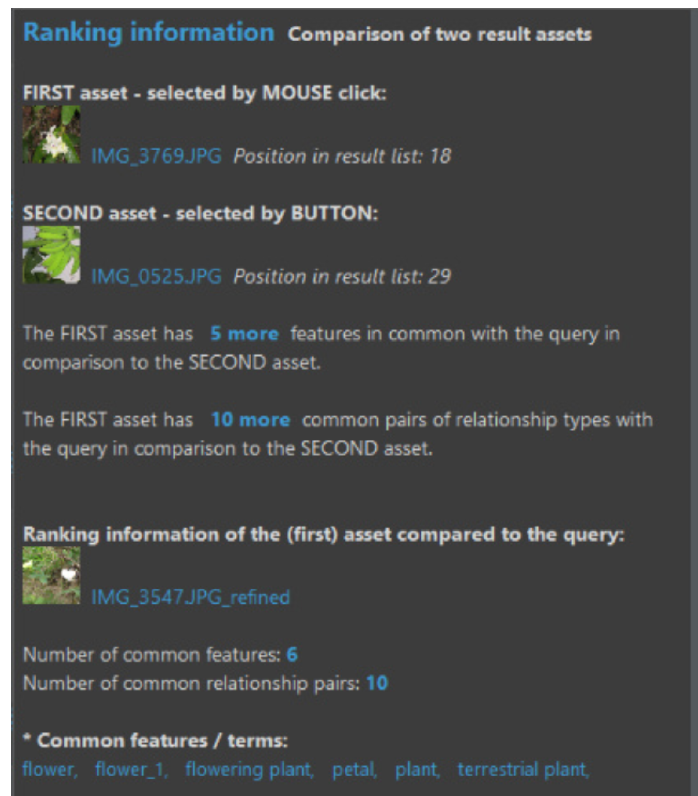
Figure 17. Visualization of ranking and comparison